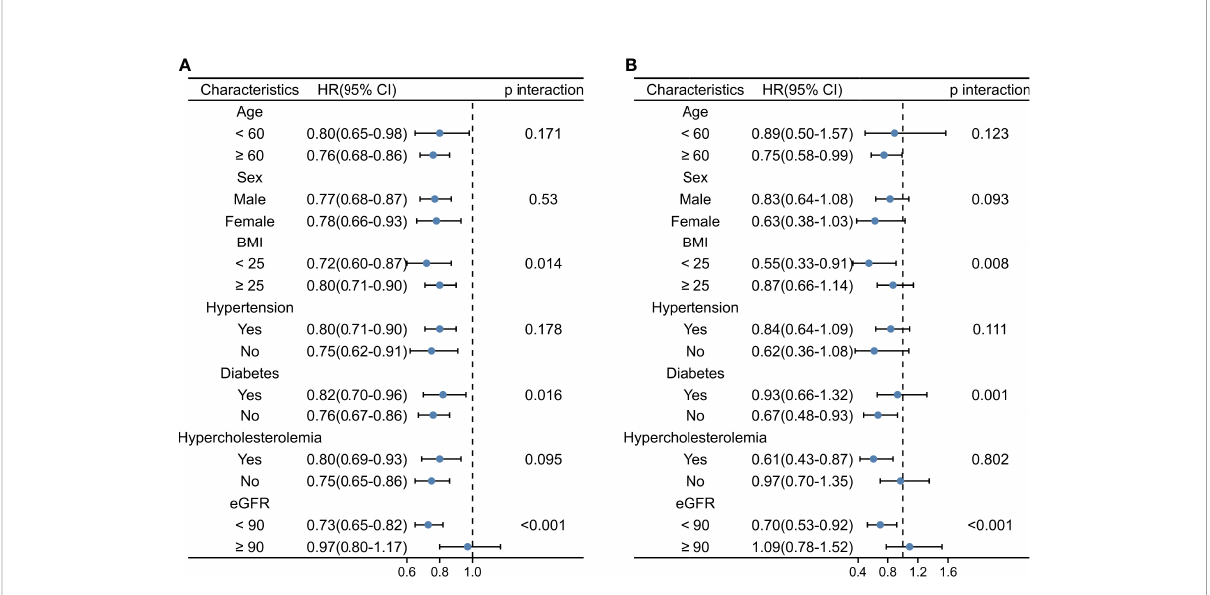
FIGURE 3 Strati fi ed Analysis of the FT3/FT4 Ratio and Risk of All-cause Mortality and Cardiovascular Mortality. (A) Strati fi ed Analysis of the FT3/FT4 Ratio and Risk of All-cause Mortality. (B) Strati fi ed Analysis of the FT3/FT4 Ratio and Risk of Cardiovascular Mortality. FT3, free triiodothyronine; FT4, free thyroxine; BMI, body mass index; CVD, cardiovascular